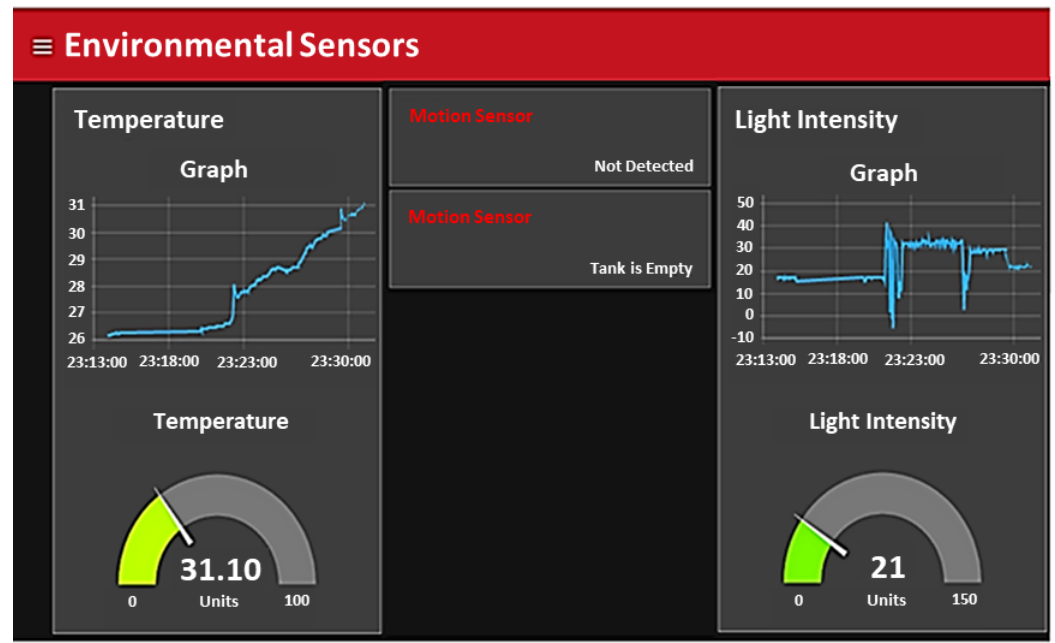
Figure 7. The status of environmental sensors that are used in the home for home automation.